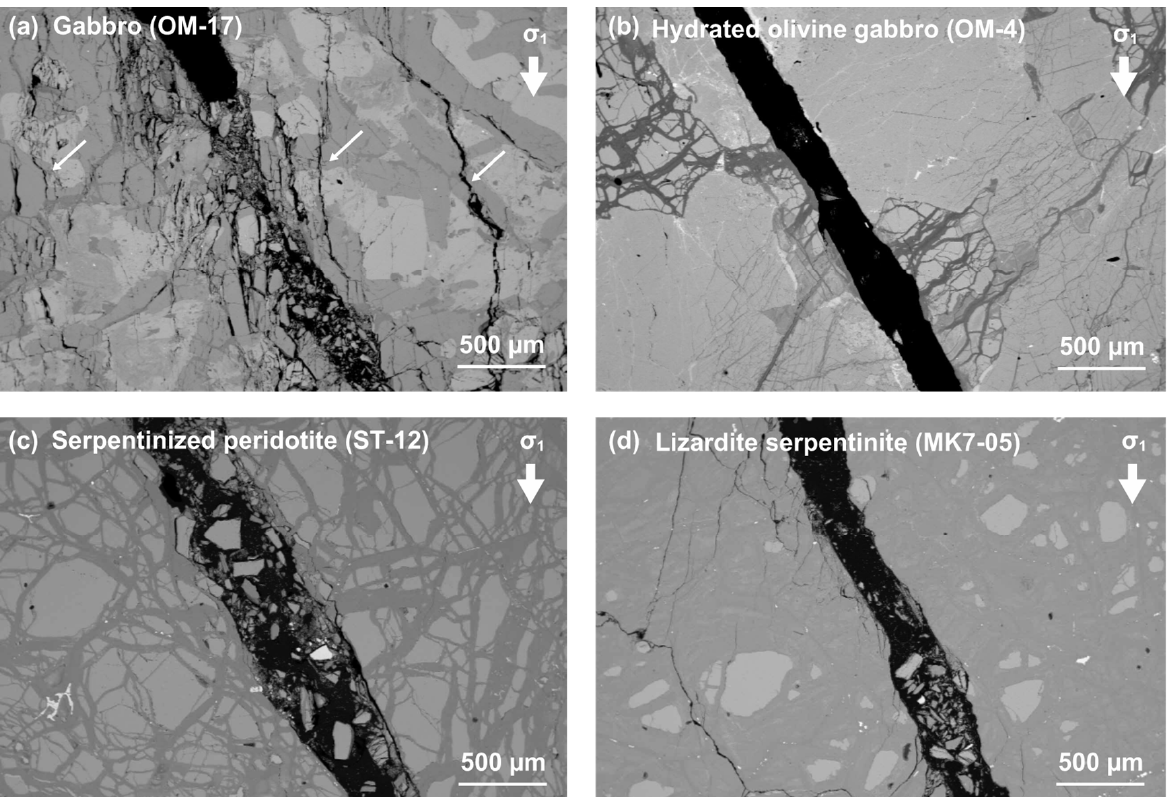
Figure 7. SEM images of fault planes in the failed samples recovered after deformation experiments: ( a ) gabbro, ( b ) hydrated olivine gabbro, ( c ) serpentinized peridotite, and ( d ) lizardite serpentinite. The loading axis σ 1 is in the vertical direction. White arrows in ( a ) indicate stress-induced cracks.